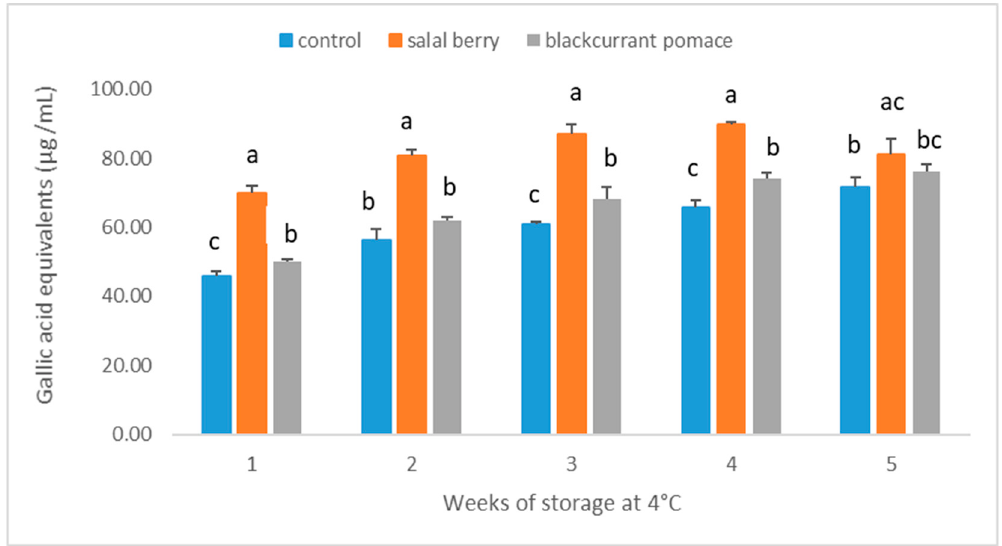
Figure 1. Total phenol content of yogurt beverages during cold storage. Results are presented as means ± SD. Different low case letters denote significant differences at each time point ( p < 0.05).